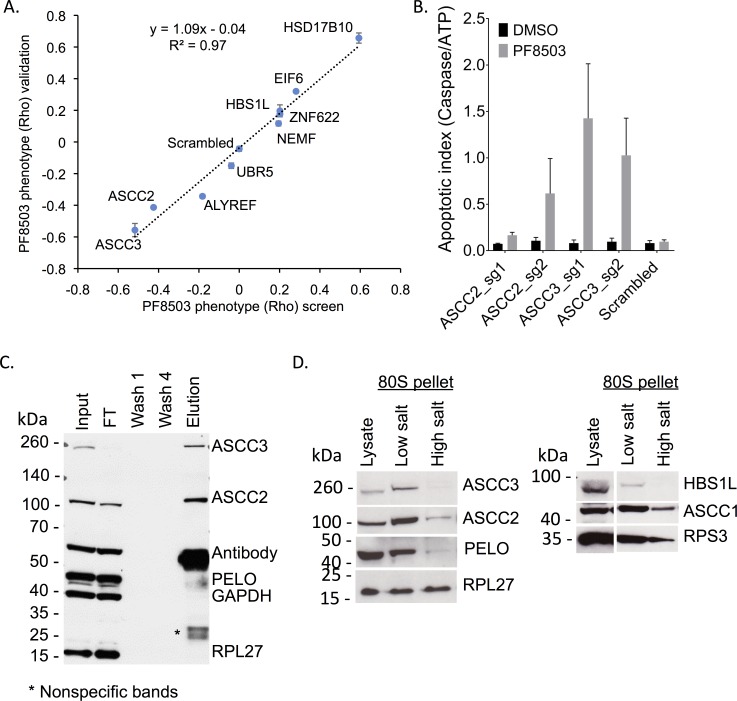
Roles of ASCC2 and ASCC3 in PF8503-dependent toxicty.(A) Comparison of the Rho phenotype in the CRISPRi screen to relative cell viability in individual gene knockouts. K562_dCas9-KRAB cells with individual sgRNAs targeting genes of interest were competed against cells with a scrambled sgRNA, in the presence of 7.5 μM PF8503. Experiments were carried out in biological triplicate with the average log2(fold change) and standard deviation shown. (B) Effect of treatment with PF8503 (7.5μM) on K562-dCas-KRAB cell lines expressing two different sgRNA targeting either ASCC2 or ASCC3 expression. The apoptotic index, defined as the ratio of Caspase 3/7 levels to ATP levels, measured after 6 days of 7.5 μM PF8503 or DMSO control treatment. Experiment performed in triplicate, with the average and standard deviations shown. (C) Western blot of immunoprecipitation of ASCC3 from the cytoplasm of HEK293T cells. Input, cell lysate; FT, flow-through supernatant; Wash 1 and 4, Bead washes; Elution, Proteins extracted from beads. Gel is representative of duplicate experiments. (D) Western blots obtained after isolation of 80S ribosomes from K562-dCas9-KRAB cell lines expressing scrambled sgRNA, using a sucrose cushion at low (200 mM) or high (400 mM) potassium acetate concentration. Gels are representative of experiments carried out in duplicate.